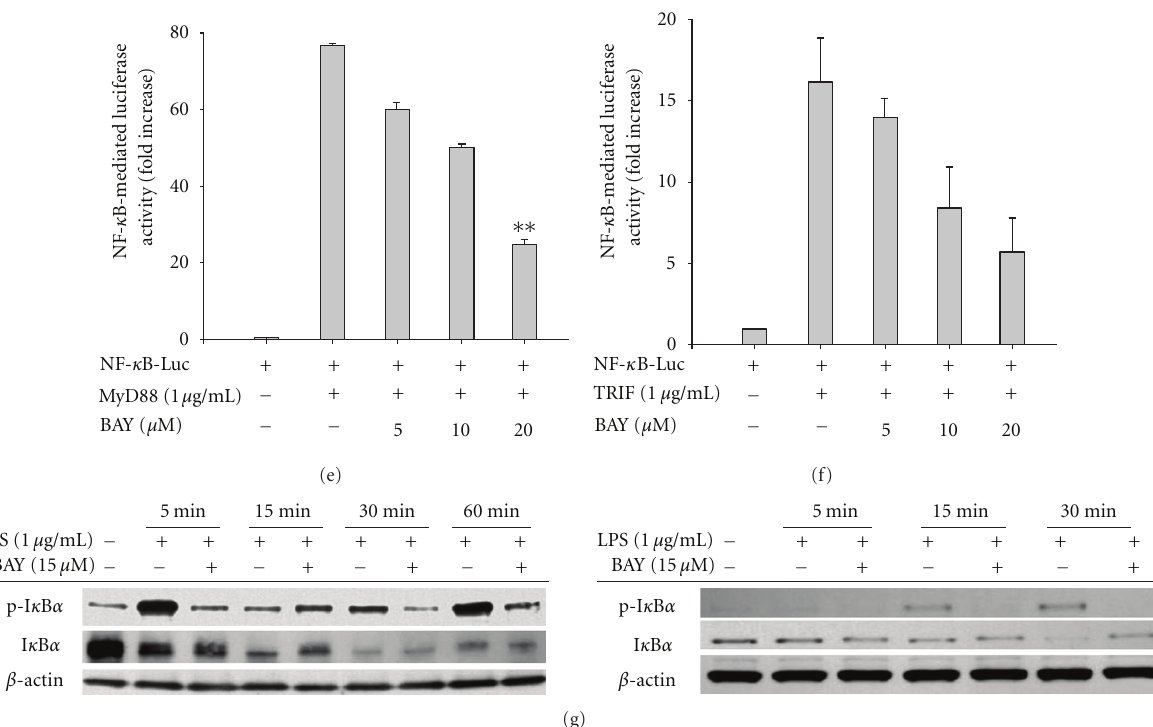
Figure 2: E ff ect of BAY on transcriptional activation of NF- κ B. (a left panel, b, and g) Translocated or phosphorylated levels of NF- κ B subunits from nucleus (a) or whole lysates (b) of RAW264.7 cells (a, b, and g left panel) or peritoneal macrophages (g right panel) treated with BAY (15 μ M) in the presence or absence of LPS (1 μ g/mL) for indicated times, evaluated by immunoblotting. (c left panel to f) HEK293 cells cotransfected with NF- κ B-Luc construct (1 μ g/mL) and β -gal (transfection control) were treated with BAY (0 to 20 μ M) in the presence or absence of PMA (100nM) or by cotransfection with NF- κ B activation inducers (MyD88, TRIF, and TBK1). Luciferase activity was measured using a luminometer. (a right panel and c right panel) Viability of RAW264.7 (a right panel) and HEK293 (c right panel) cells treated with BAY (0 to 20 or 30 μ M) for 2 or 24h was examined by MTT assays. ∗ P < 0 . 05 and ∗∗ P < 0 . 01 compared to the